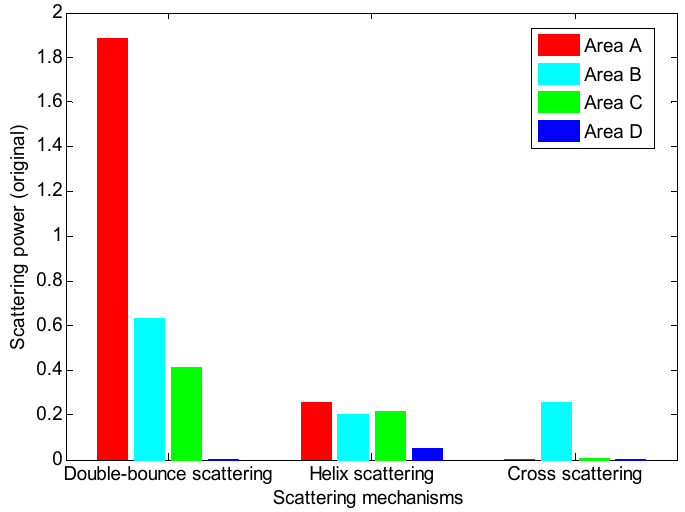
Figure 5. Quantitative comparison among the double-bounce, helix and cross scattering powers from our decomposition for four selected areas in Figure 4d.